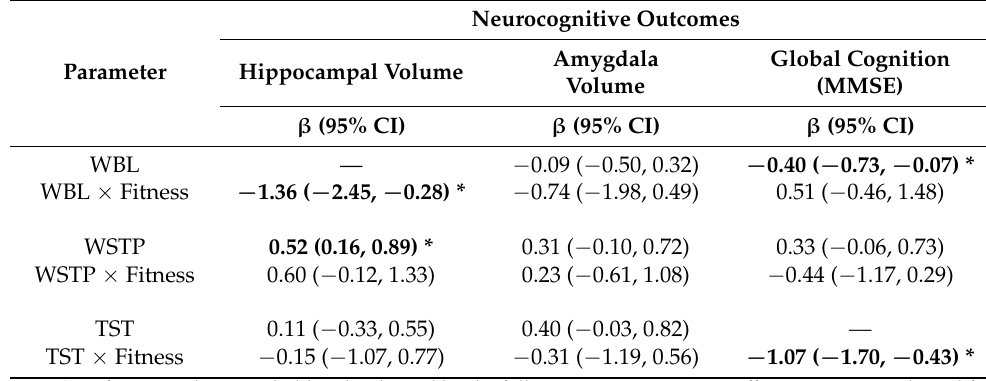
Table 2. Sleep × fitness (HRR M ) interaction for regional brain volume and global